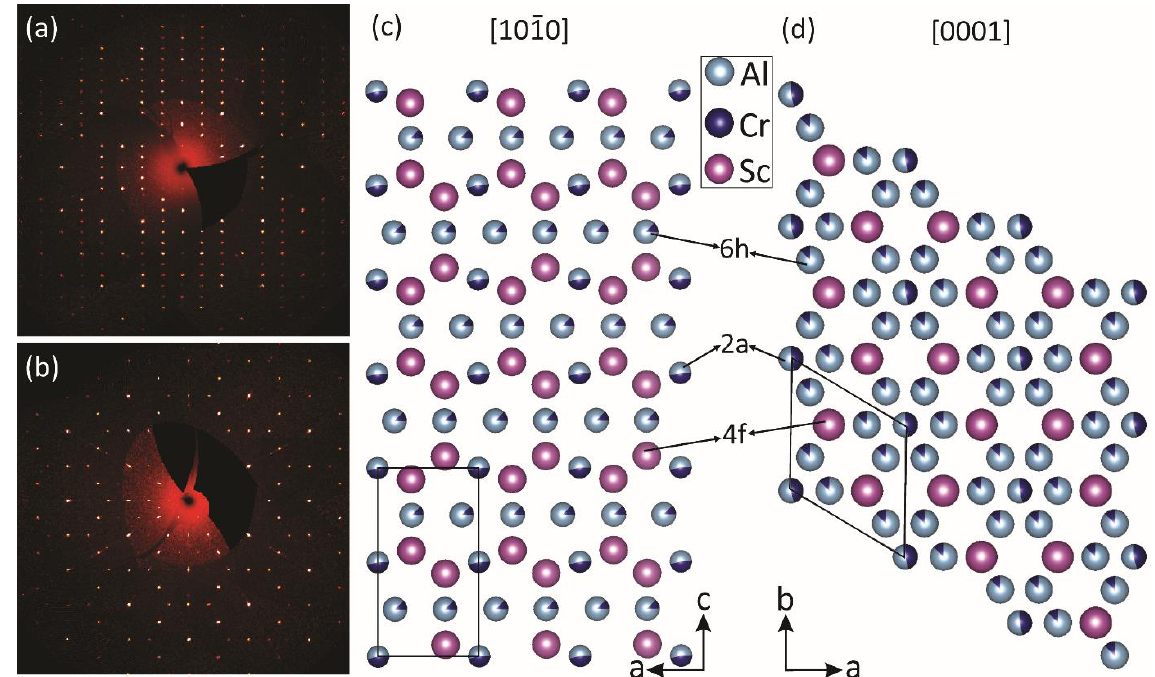
(cid:2) (cid:3) 0110